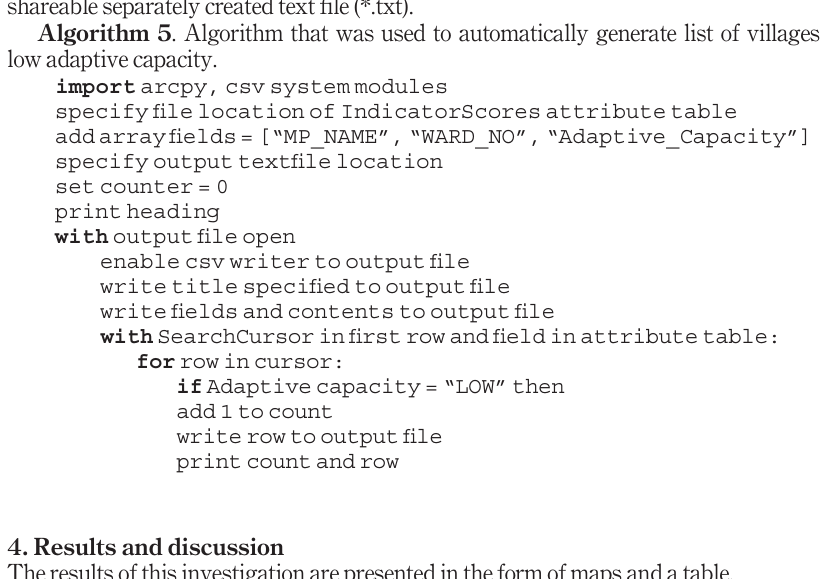
Algorithm 5 . Algorithm that was used to automatically generate list of villages with low adaptive capacity. import arcpy, csv system